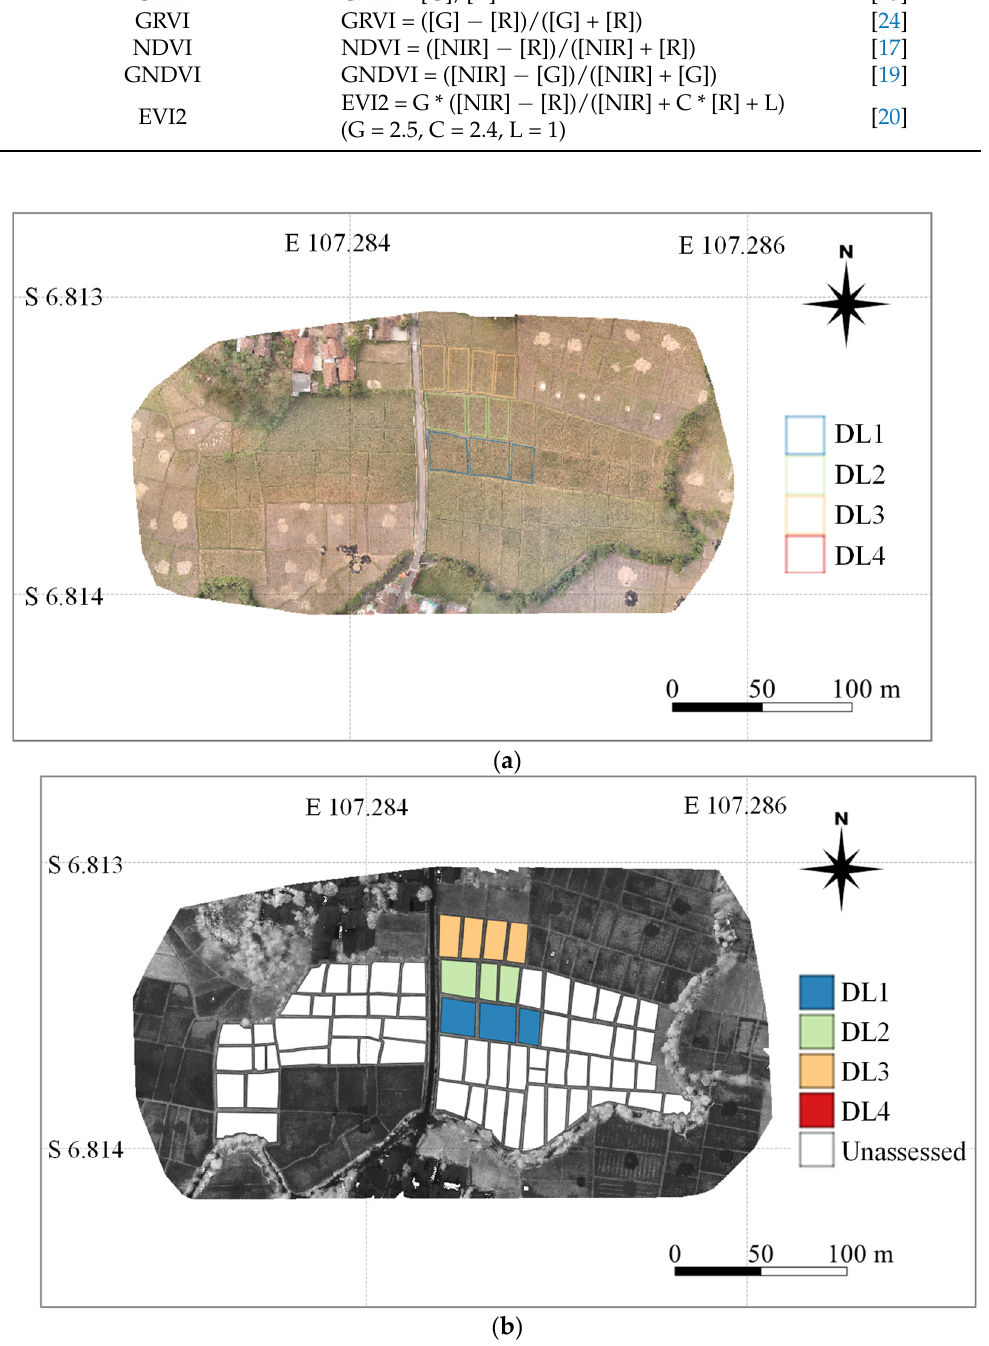
Figure 3. Examples of polygons for assessed and unassessed paddy fields in Karangwangi: ( a ) as ‐ sessed fields are indicated in an ortho ‐ mosaic image of RGB; ( b ) assessed and unassessed fields are sessed fields are indicated in an ortho-mosaic image of RGB; ( b ) assessed and unassessed fields are shown in a calculated EVI2 image from multispectral image. shown in a calculated EVI2 image from multispectral